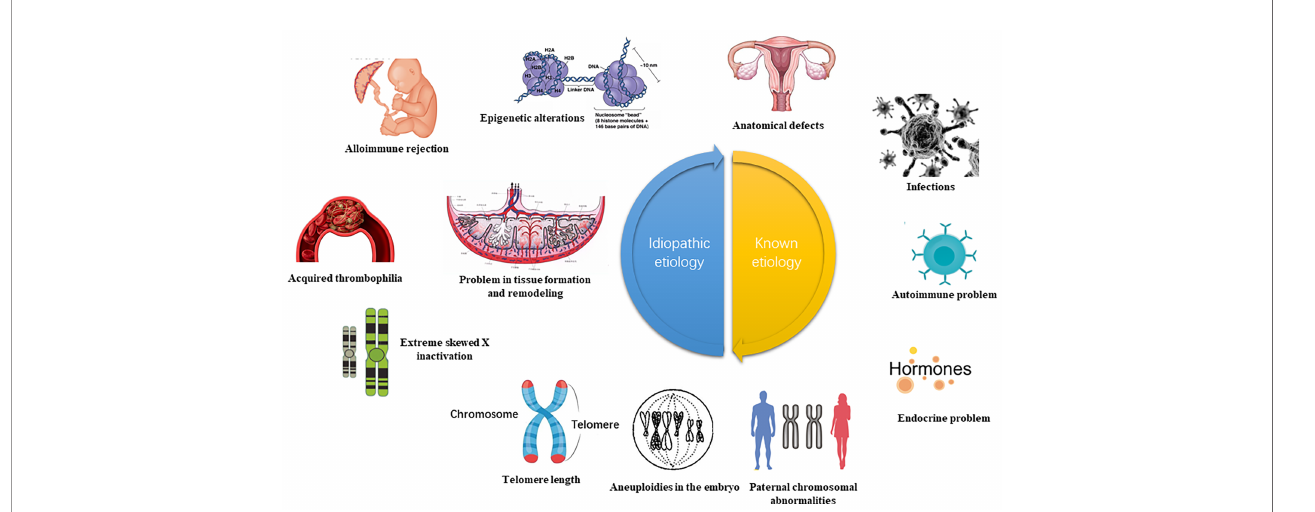
FIGURE 1 | High risk of RPL (recurrent spontaneous abortion) (5). The etiology of RPL can be diagnosed by interrogation, clarifying the gestational age and characteristics of the miscarriage. Early RPL may be related to abnormal chromosome structure and function, immune dysfunction, endocrine disorder, abnormal reproductive system, prethrombotic state (PTS), poor environment and living habits. The function of the uterine cervical, the development of amniotic fl uid, and the umbilical cord may also be linked to late RPL. This review focuses on the abnormal immune function of RPL and analyze the important role of DNA